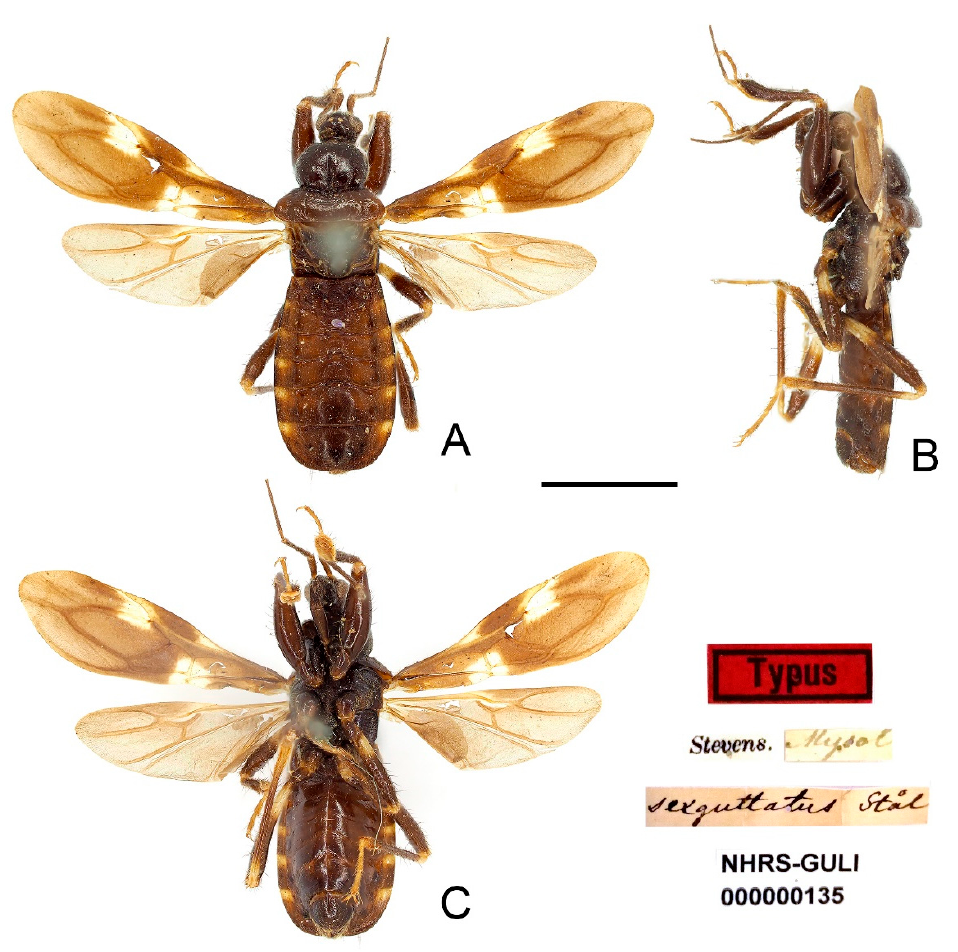
Figure 13. Sigicoris sexguttatus comb. nov. , lectotype male, habitus. ( A ) Dorsal view. ( B ) Lateral view. ( C ) Ventral view. Scale bar = 3.00 mm. Diagnosis: Body dark brown, base of mid and hind tibiae and basal 1/3 of mid and hind femora yellowish white to pale yellow, hemelytron dark brown with three yellowish white spots, segment of connexivum with basal half yellowish white to yellow and apical half dark brown; width of interocellar space subequal to width of ocellus; first visible segment of rostrum longer than third segment; pronotum with anterior margin nearly straight, collar process prominent, lateral pronotal angle rounded; fore tibia with fossula spongiosa occupying half of tibial length, mid tibia with fossula spongiosa occupying 2/5 of tibial length.